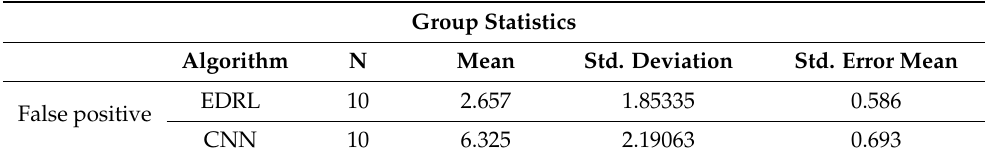
Table 9. Group statistics for false positive comparison of EDRL vs. CNN algorithms to measure the mean, standard deviation, and standard error